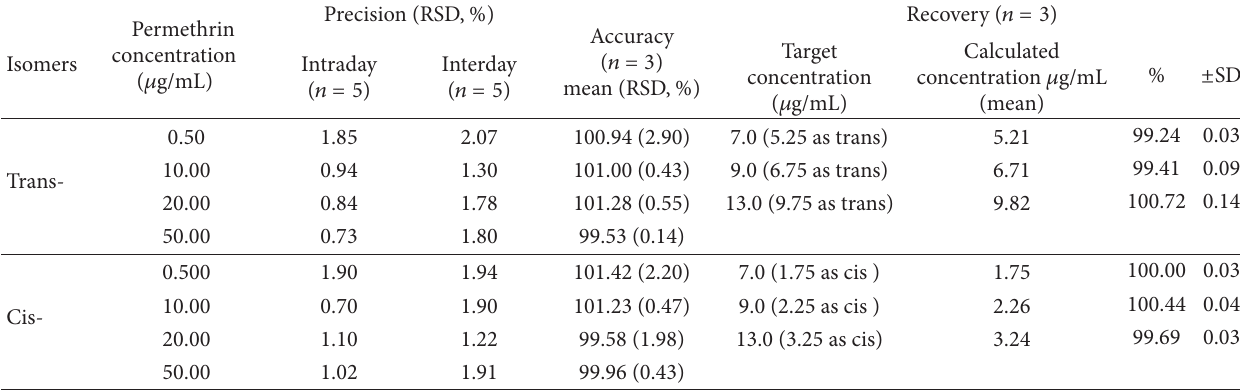
T 2: Precision, accuracy, and recovery data for the proposed